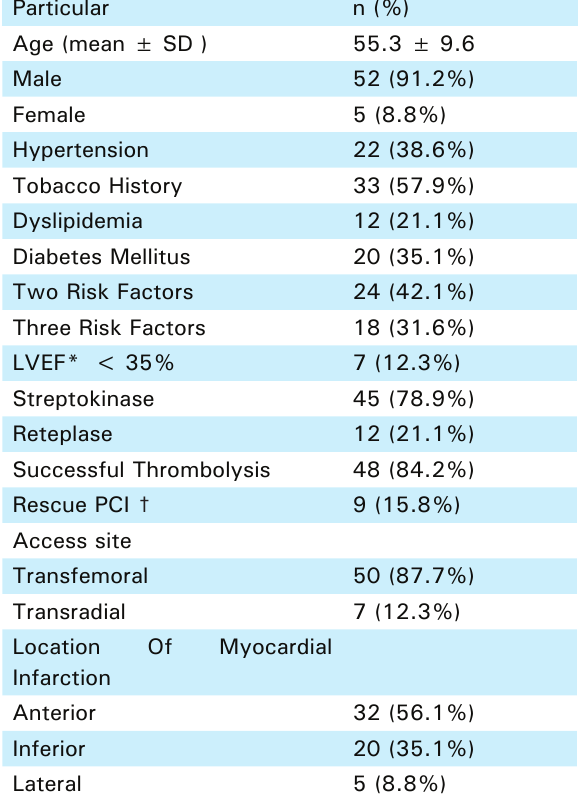
table 1. baseline characteristics.